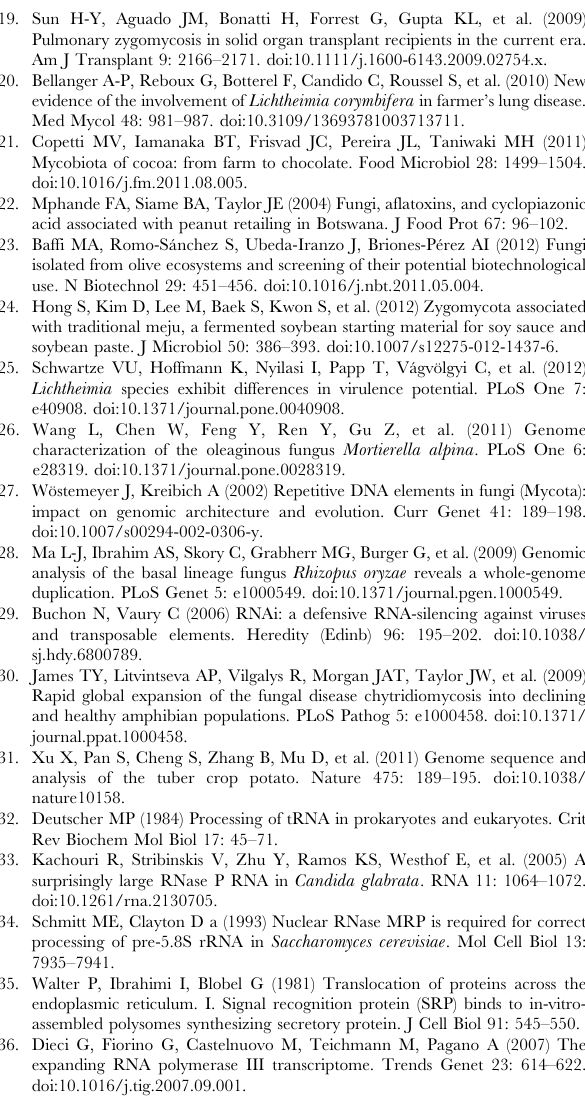
Table S3 Overview of ncRNAs found in basal fungi. op – Close/Part to Operon; pg – Pseudogene; Ror – R. oryzae ; Lco – L. corymbifera ; ? – candidate. Table S4 Sequencing and mapping statistics of RNA sequenc- ing. (XLS) Table S5 Signalling pathway components included in the study and orthologues identified in L. corymbifera . (PDF) Table S6 Classification and gene IDs of putative protein phosphatases in the L. corymbifera genome. Table S7 RNA-Seq mapping and differentially expressed genes. (XLS) Table S8 Potential alternatively spliced genes in L. corymbifera and confirmation of alternative transcripts by RNA-Seq data.